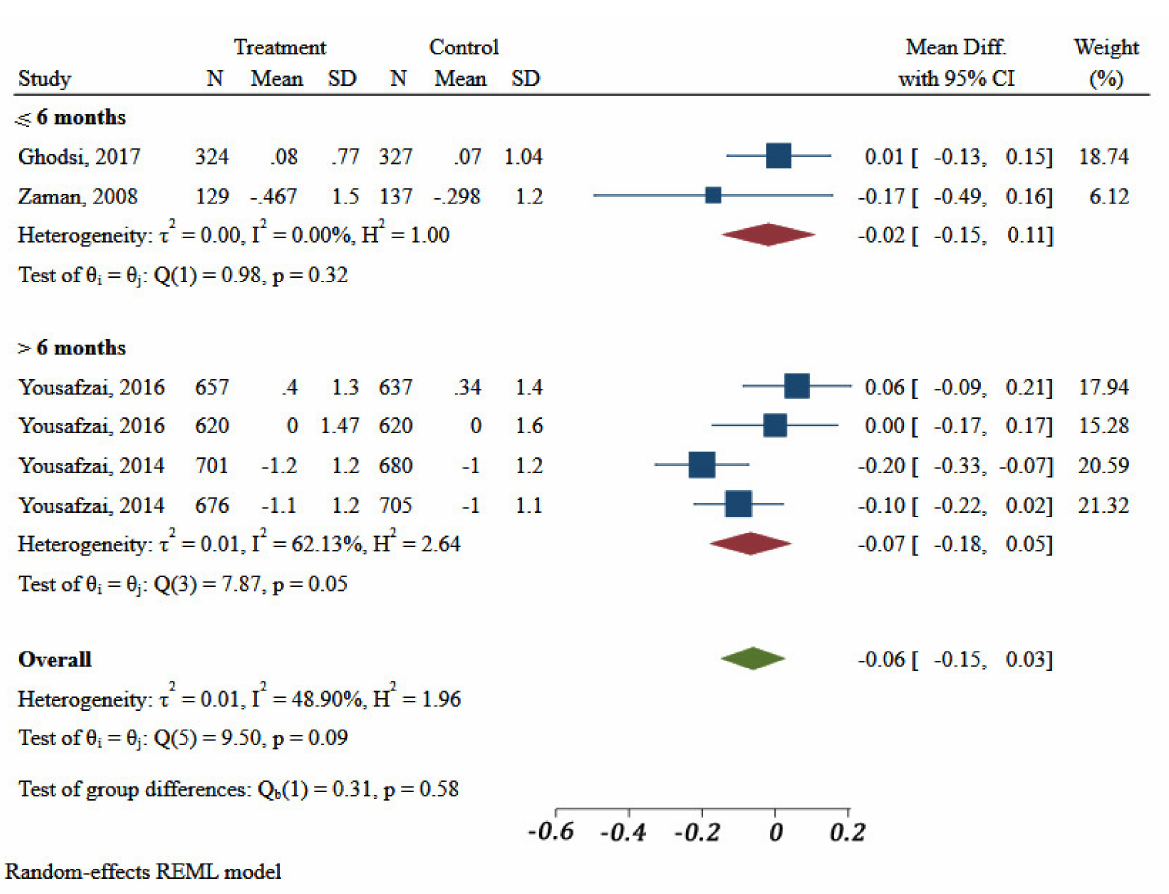
Figure 2. Impact of different community-based nutrition interventions on Height-for-Age Z-score of children under 5 in Eastern Mediterranean Region.